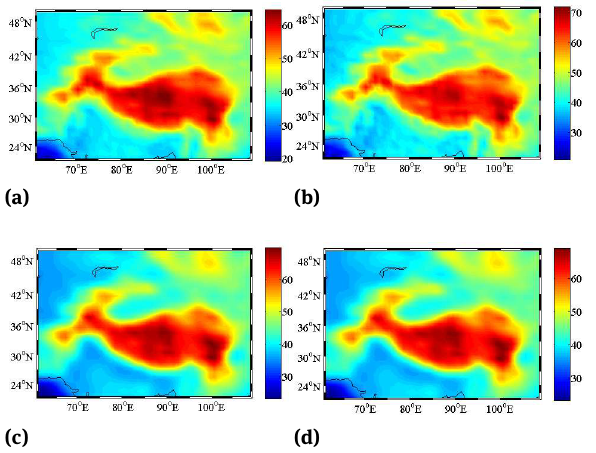
Figure 4: Maps of Moho models computed by a) SVMM, Eq. (2h), b) VMM Eq. (1e) , c) SFLEX Eq. (2h) with Eq. (2i) and d) FLEX Eqs. (2h) with Eq. (3c) [km]